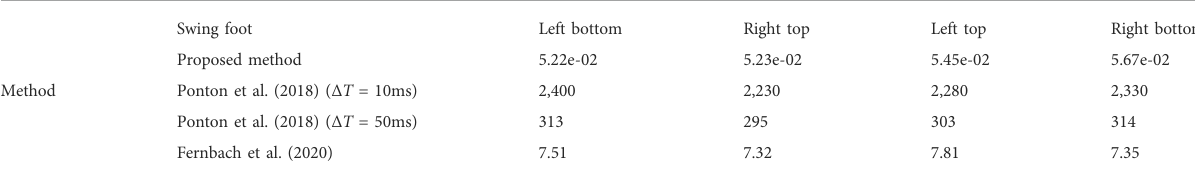
TABLE 3 Computation time comparison benchmark of CoM trajectory optimization for two different climbing scenarios between the proposed algorithm and other existing methods. Computation time is averaged over 100 tries for each scenario. Computation time [ms] for fl at slope climbing scenario(motion horizon = 0.65 s) Swing foot Left bottom Right top Left top Right bottom Proposed method